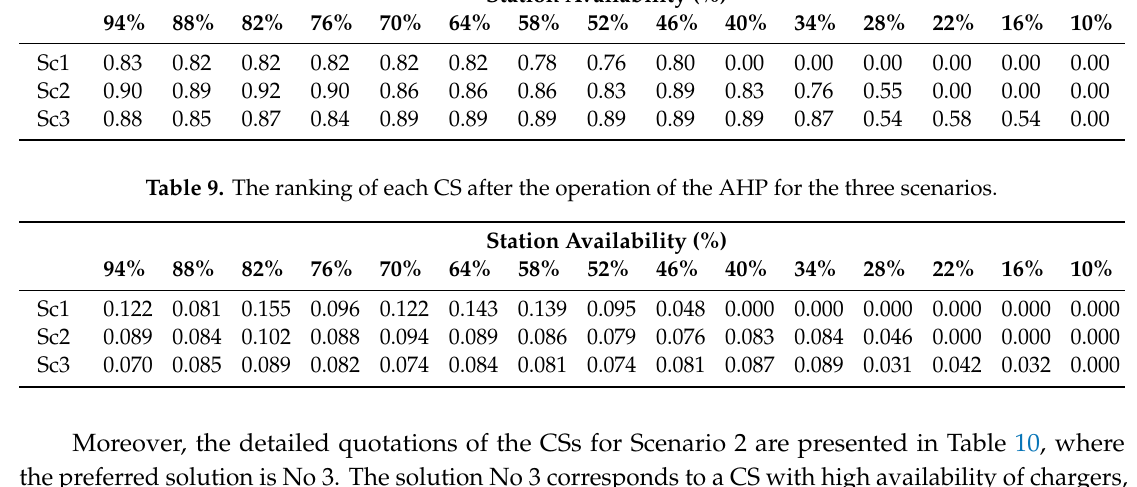
Table 8. The objective function value of each CS after the operation of the PSO, for the three scenarios. Station Availability (%)